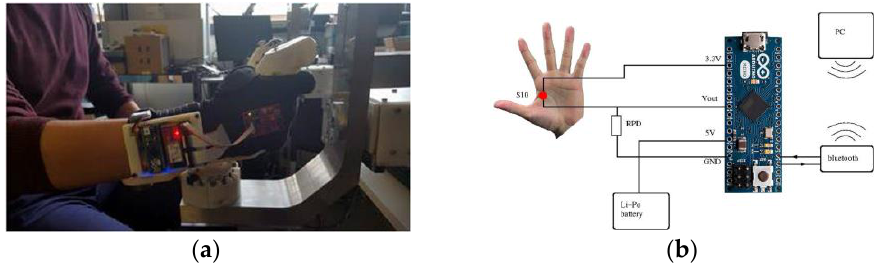
Figure 3. ( a ) Snapshot view of right-hand glove in action. ( b ) Design chart of the single-sensor-to-software operating system.